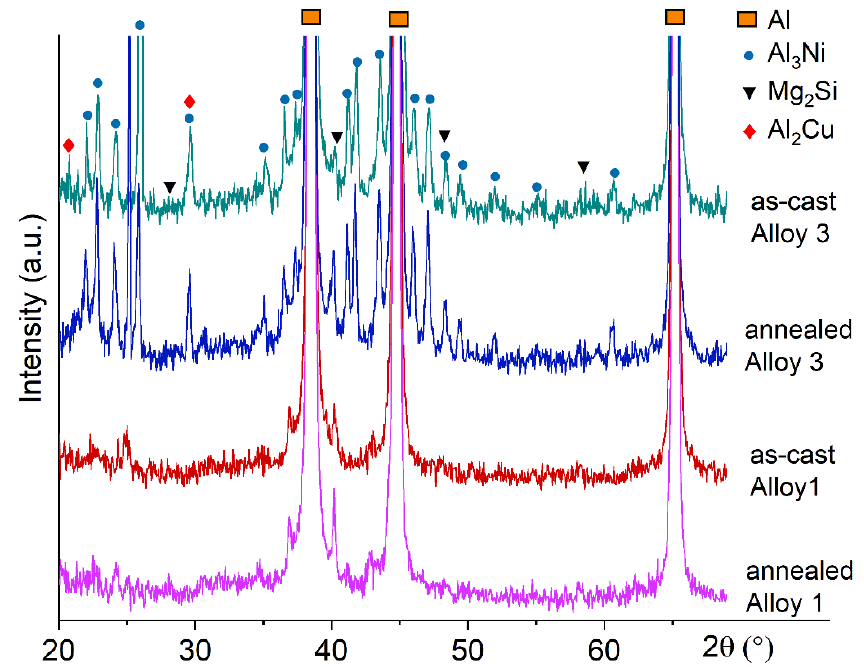
Figure 2. XRD spectrums for the alloys 1 (Al-1.2Mg-0.7Si-1.0Cu-0.5Ni) and 3 (Al-1.2Mg-0.7Si-1.0Cu-4Ni) in as-cast and annealed states.